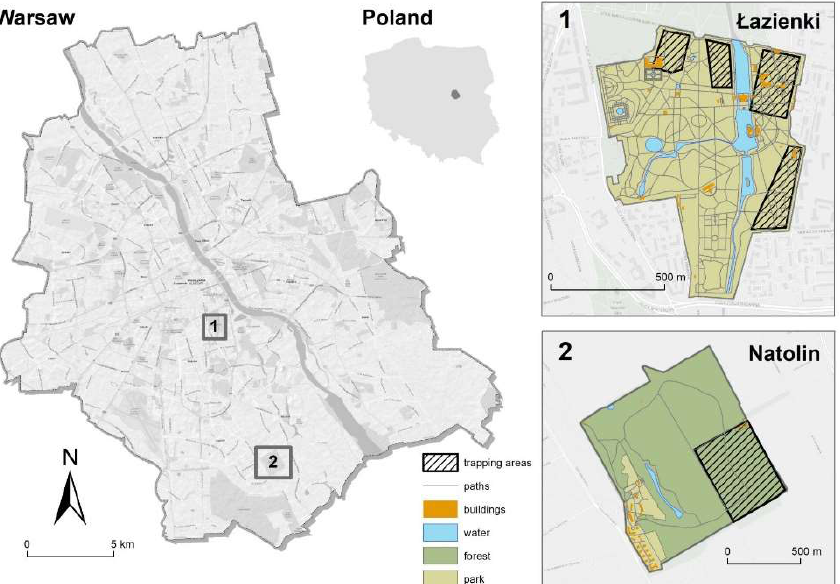
Figure 1. Study areas: 1. Royal Łazienki Museum (an urban park) and 2. Natolin Forest Reserve (an urban forest) in Warsaw, where red squirrels were live-trapped. Approximate locations of trapping areas are shown.